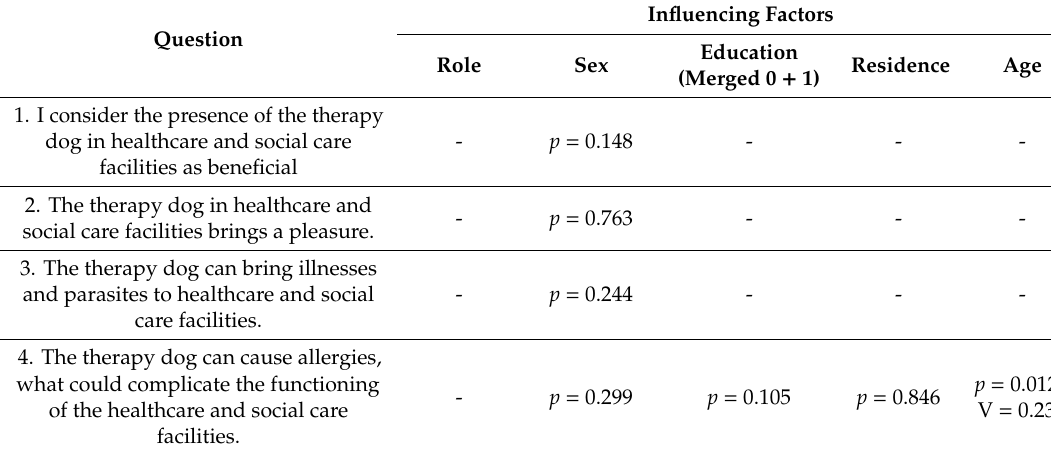
Table 1. Table of dependent factors after